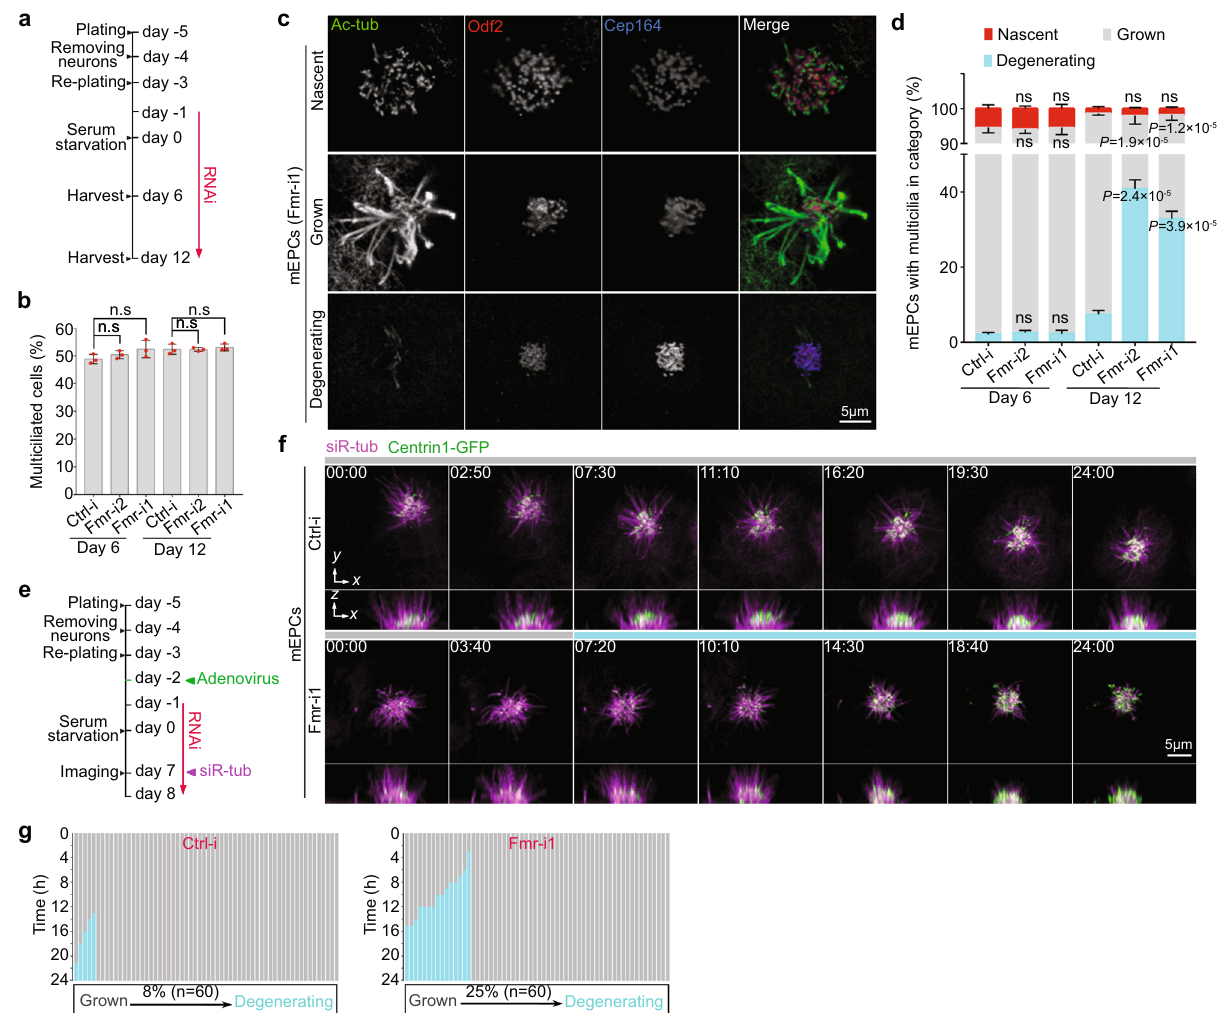
Fig. 5 Depletion of FMRP promotes degeneration of ependymal multicilia. Pooled data were from three independent experiments and are presented as mean ± s.d. Two-tailed student ’ s t -test against control populations: ns, no signi fi cance. a Experimental scheme. mEPCs transfected with siRNA (Ctrl-i or Fmr-i1) were harvested at day 6 or 12 to assess the status of multiciliation. b Fmrp was dispensable for multiciliated cell formation. 1280 (Ctrl-i, Day 6), 1456 (Fmr-i2, Day 6), 1501 (Fmr-i1, Day 6), 1350 (Ctrl-i, Day 12), 1225 (Fmr-i2, Day 12), and 1360 (Fmr-i1, Day 12) cells from three biologically independent experiments were scored. c Representative patterns of multicilia in day-12 mEPCs transfected with Fmr-i1. Odf2 and Cep164 served as basal body markers. Nascent: short multicilia with scattered basal bodies; Grown: long multicilia with packed basal bodies; Degenerating: a few uneven multicilia with overwhelming numbers of tightly packed basal bodies. d Depletion of Fmrp increased mEPCs with degenerating multicilia at day 12. mEPCs were scored following the criteria in c . 635 (Ctrl-i, Day 6), 789 (Fmr-i2, Day 6), 895 (Fmr-i1, Day 6), 883 (Ctrl-i, Day 12), 690 (Fmr-i2, Day 12), and 899 (Fmr-i1, Day 12) cells from three biologically independent experiments were scored. e Experimental scheme for tracing dynamic changes of multicilia through live imaging. mEPCs were infected with adenovirus to express Centrin1-GFP, followed by siRNA (Ctrl-i or Fmr-i1) transfection. Spinning disk microscopy was performed from day 7 for 24 h at 10 min intervals after the addition of siR-tub to label axonemes. At each timepoint, z-stack images were acquired at 0.5 μ m intervals for a depth of 15 μ m to suf fi ciently cover basal bodies and ciliary tips. f Representative frames showing multicilia degeneration in mEPCs transfected with Fmr-i1. Both z-projected images (x-y) and their orthogonal views of 3D-reconstructed images (x-z) are presented. The dashed line marks the middle plane of basal bodies. Time stamps are in the format of hours: minutes. g Quanti fi cation of 60 multiciliated cells in each condition. Multicilia undergoing degeneration are marked in